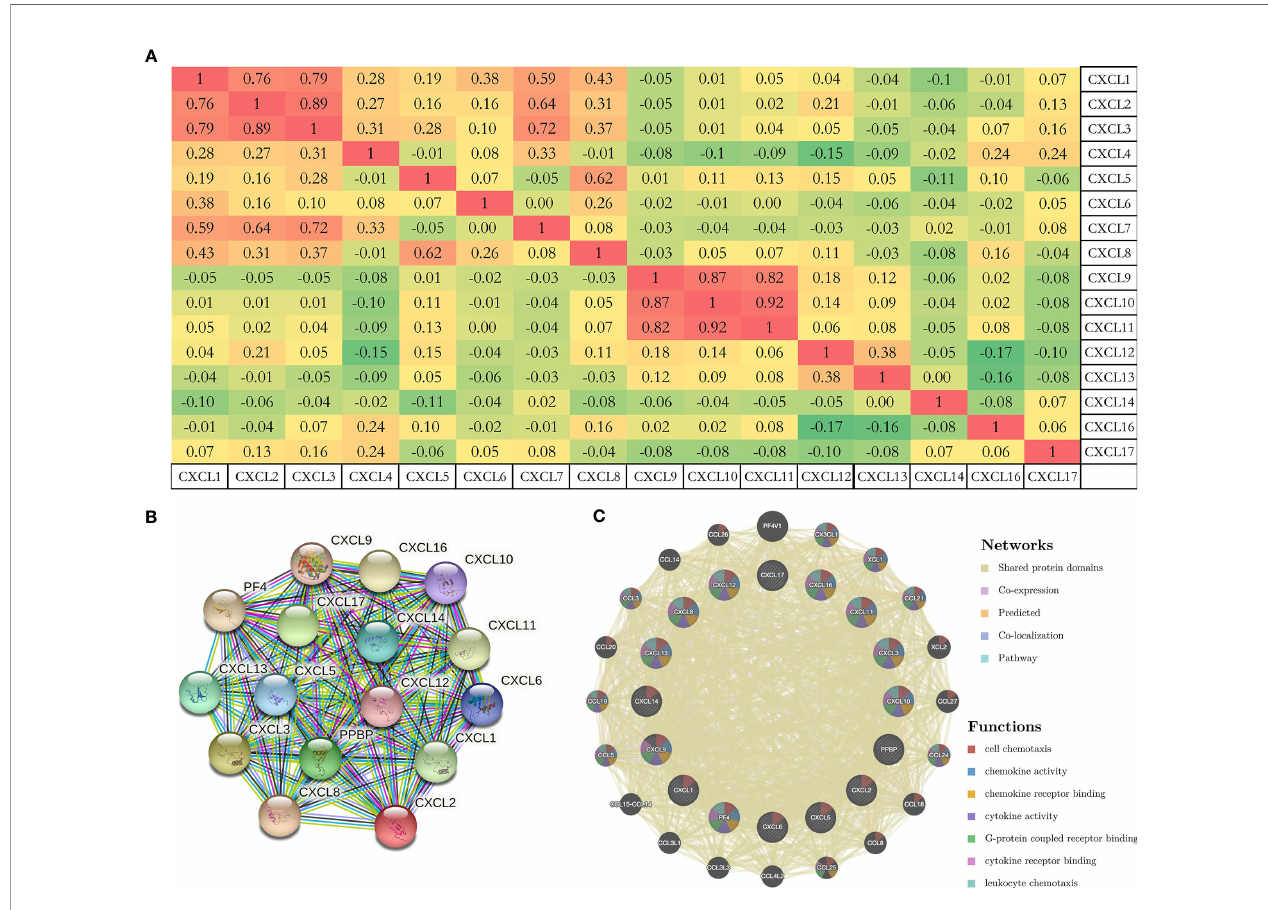
FIGURE 5 | (A) The co-expression of CXC chemokines with each other based on the Pearson ’ s correlation coef fi cient for PAAD samples (cBioportal). (B, C) PPI network and functional relationship of CXC chemokines (STRING, GeneMANIA).